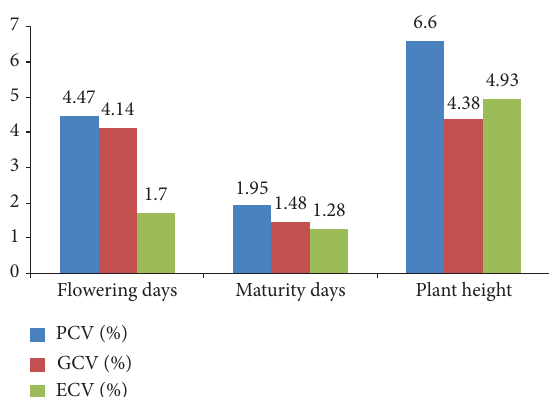
Figure 4: Comparative values of phenotypic, genotypic, and en- vironmental coefcients of variation for days to fowering, days to maturity, and plant height combined over the two seasons.